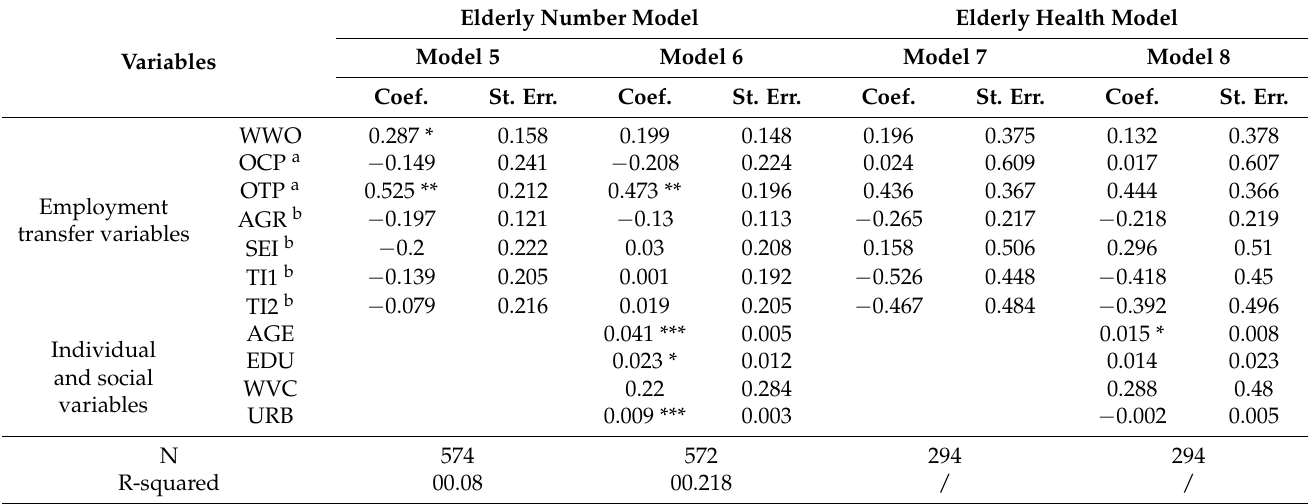
Table 5. Results of panel regression model on the number of elderly